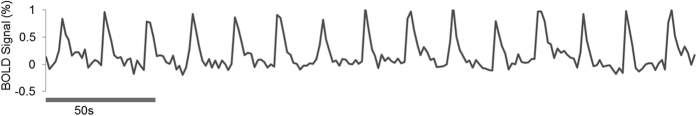
The BOLD Response Triggered by Optogenetic Activation of Cortical Neurons by Application of a Single Pulse of Light Displays no Evidence of Adaptation.The mean BOLD fMRI signal (n = 7, continuous, raw data) to 15 consecutive pulses of light (302 mW mm−2, 10 ms pulse width, ISI = 20 s).